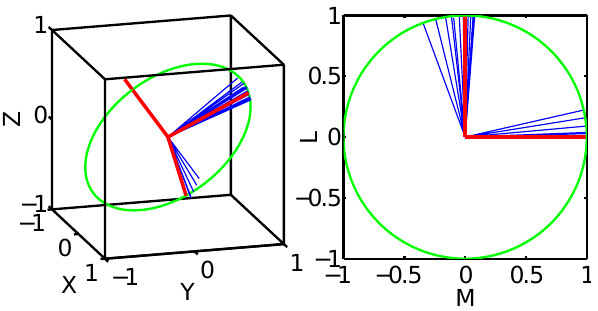
Fig. 5. (Left panel) The set of velocities V (m) · N (m) as blue lines and the structure velocity V S as the red line in the LMN coordinate system defined by three eigenvectors. (Right panel) Scatter plot of the speed V (m) as the function of V S · N (m) . The correlation coefficient is